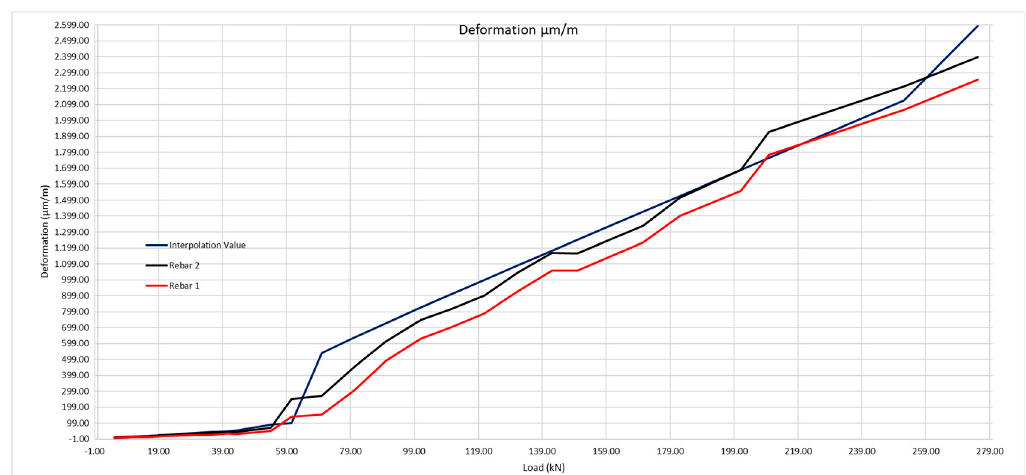
Figure 25. Deformation of the rebars with its Resistance to real traction of 2.13 MPa compared with real deformation obtained using optic fiber sensors.